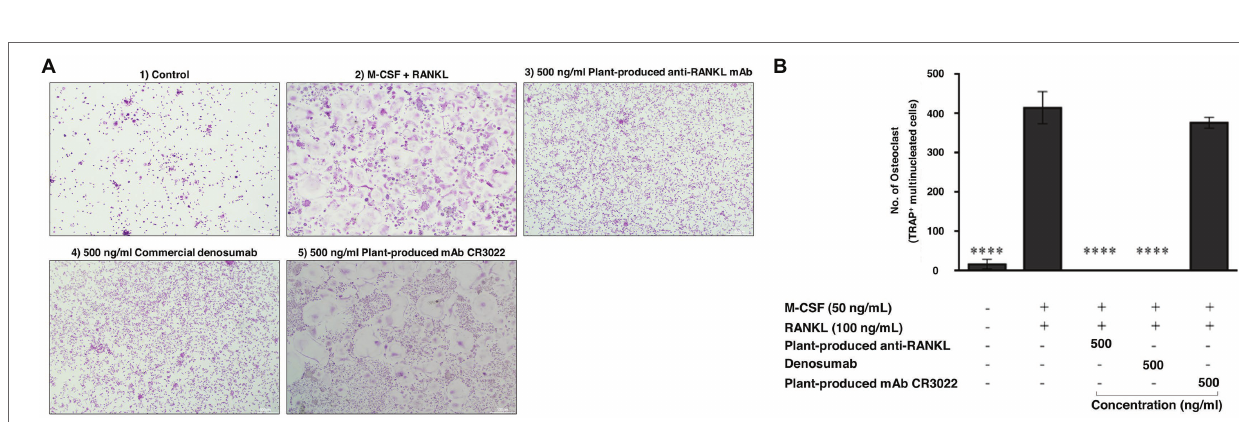
FIGURE 7 | Binding properties of plant-produced anti-RANKL mAb to human RANKL. ELISA was used to investigate the specific binding. The purified plant- produced mAb, standard human immunoglobulin G (IgG)1 (as a negative control), and commercial denosumab (as a positive control) were added to the plates coated with commercial human RANKL. The binding activity of antibody was detected with HRP-conjugated anti-human gamma chain antibody. The data are shown as the mean ± SD of triplicates.